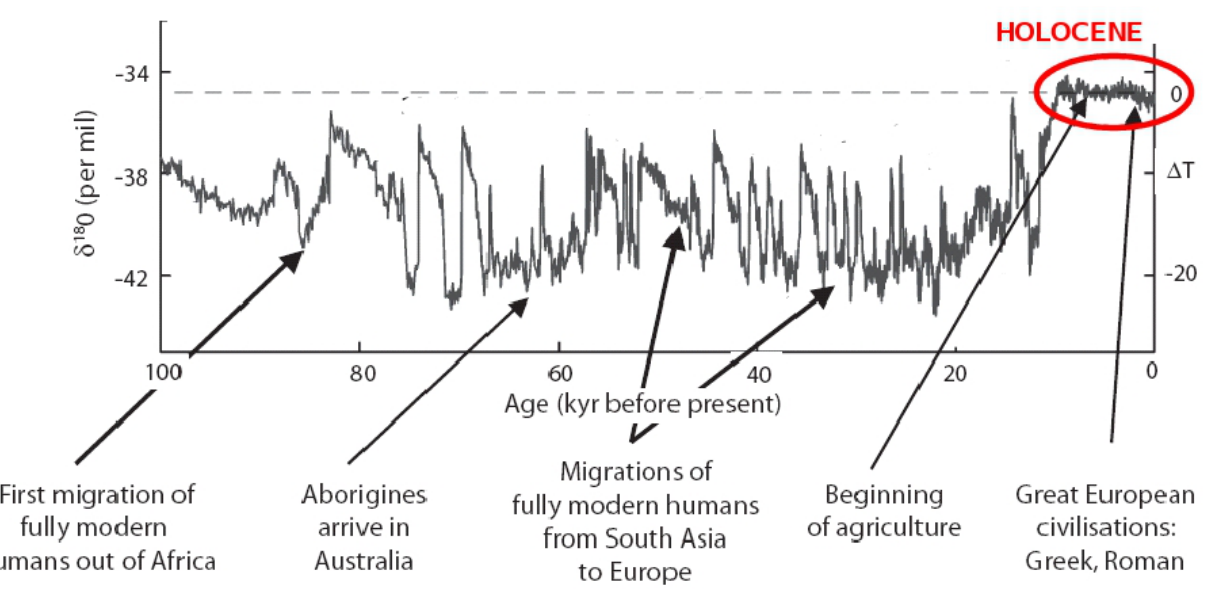
Fig. 1. The last glacial cycle of 18O (an indicator of temperature) and selected events in human history. The Holocene is the last 10 000 years. Adapted from Young and Steffen